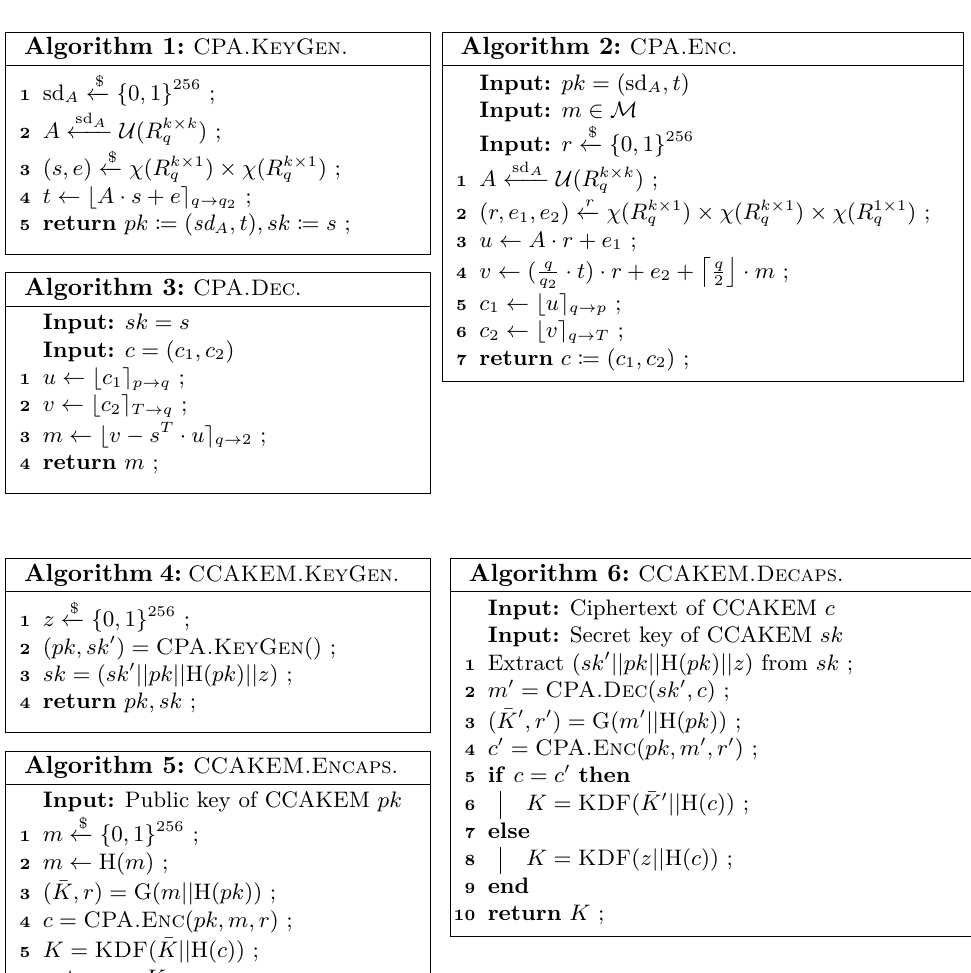
Algorithm 2: CPA.Enc .